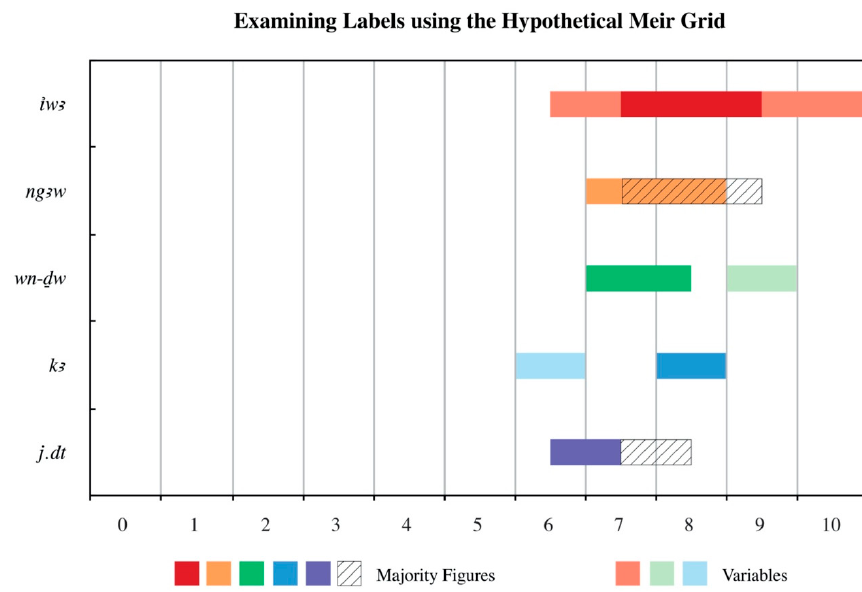
Figure 9. Examining ancient Egyptian labels using the hypothetical Meir grid.